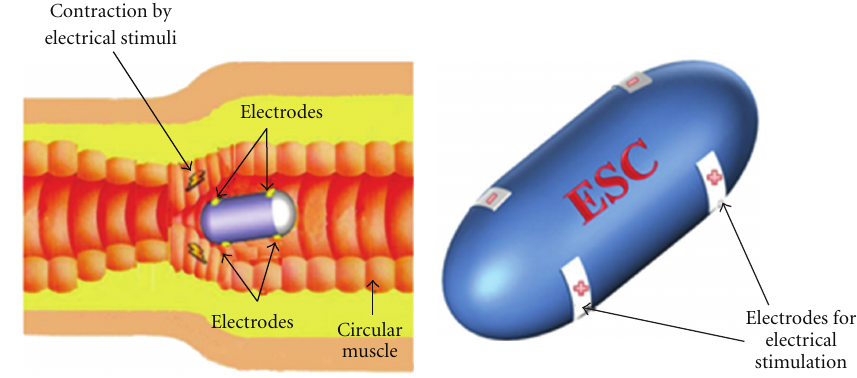
Figure 8: Capsule actuation by GI muscle stimulation [74].